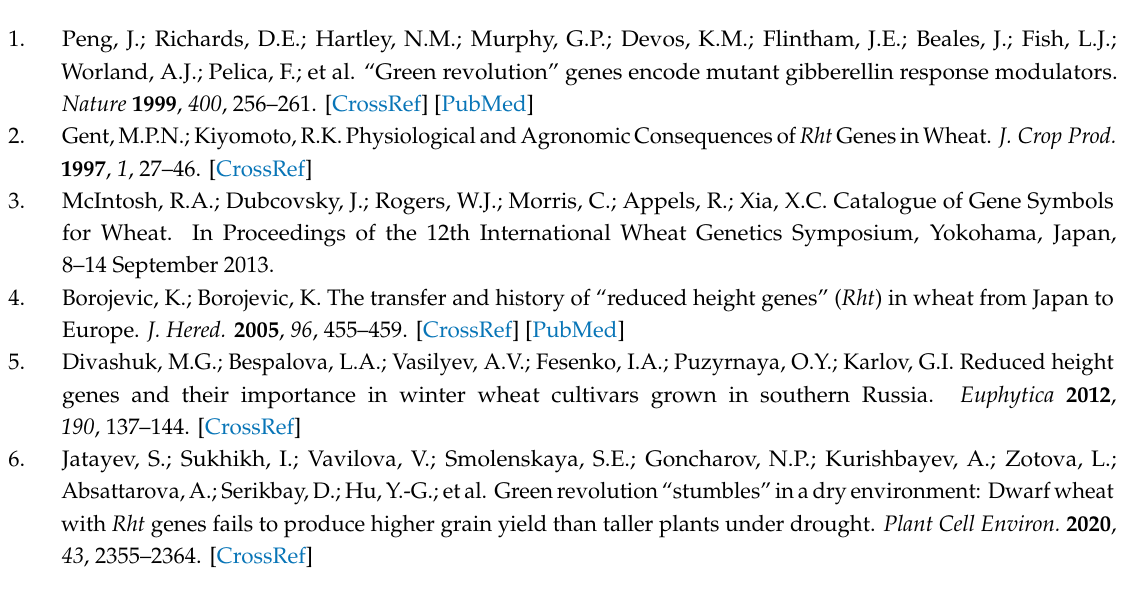
Table S1: The characteristics of the Aegilops tauschii Coss. accessions, including the genotypes for the three genes ( Rht-1 , Gid-1 , Gid-2 ) and corresponding protein isoforms involved in the gibberellin hormone signal transduction